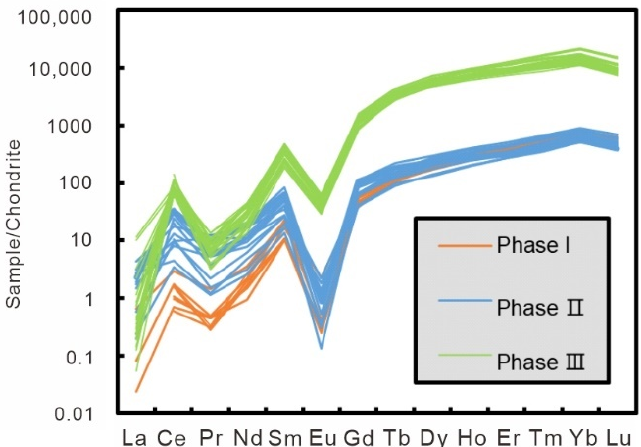
Figure 3. REE patterns of different phases zircons from pegmatite. Chondrite-normalized values are from McDonough and Sun [27] . The plots show the REE profiles of zircon (from Phase Ι to Phase ΙΙΙ ) with greater than approximately 200 ppm Fe analyses removed to avoid contamination by inclusions.